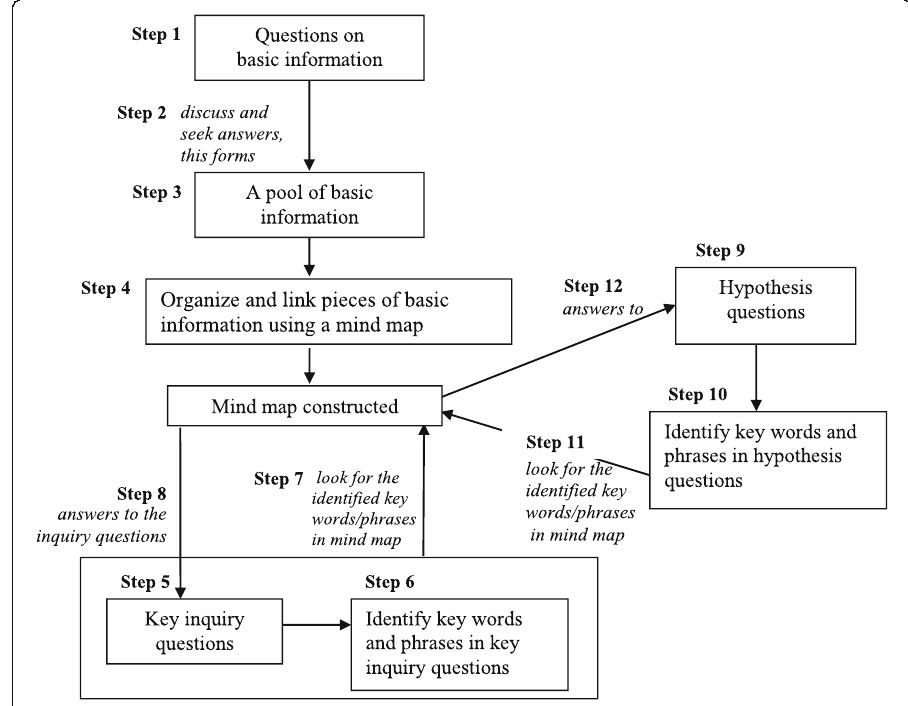
Fig. 1 A model showing how questions on key inquiry, basic information and hypothesis were used in sequential steps by group F which was most successful in generating sound and strong